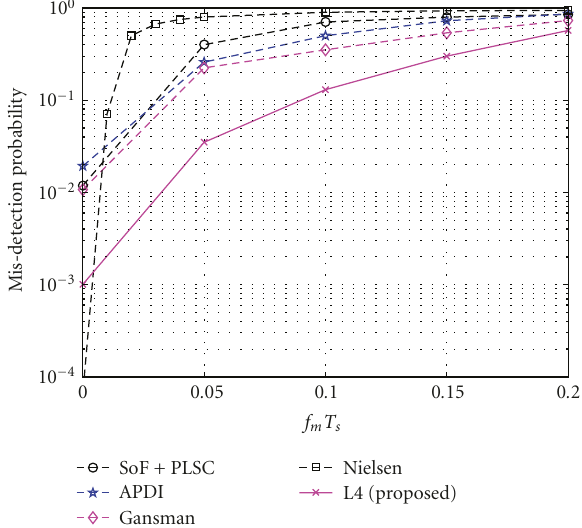
Figure 10: Performance comparison with coherent, di ff erential, and mixed-type detectors (FAR = 10 − 3 , SNR =